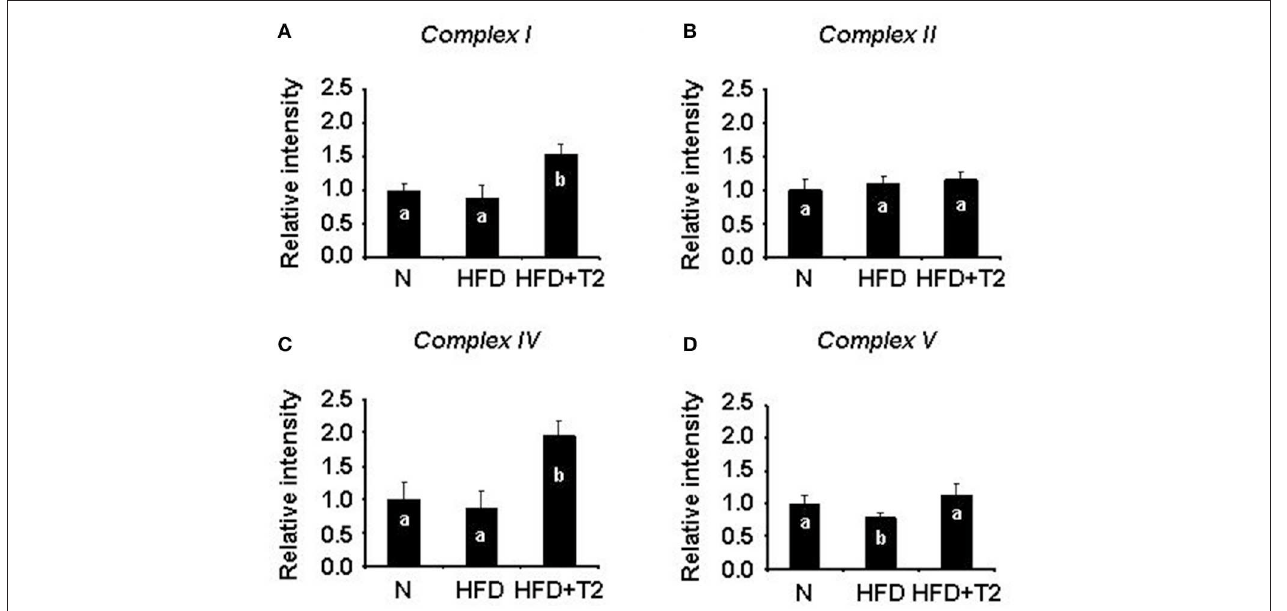
FIGURE 4 | BN-PAGE-based in-gel activity of individual mitochondrial respiratory complexes from gastrocnemius muscle of N, HFD, and HFD + T2 rats. (A) In-gel activity of complex I. (B) In-gel activity of complex II. (C) In-gel activity of complex IV. (D) In-gel activity of complex V. Protein extracts were prepared for each animal, and each individual was assessed separately. Data were normalized to the value obtained for N animals, set as 1, and presented separately for each treatment (means ± SD; n = 6). Bars labeled with dissimilar letters are significantly different ( P < 0.05).